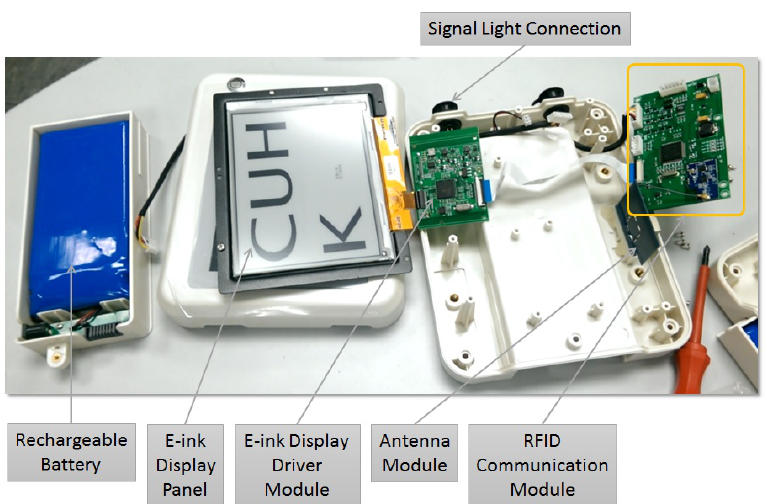
Figure 3. Several positioning readers installed in the facility.